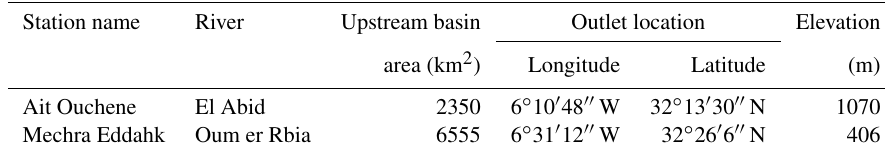
Table 1. Hydrological and geographical information of the analysed catchments at the Oum er Rbia basin.